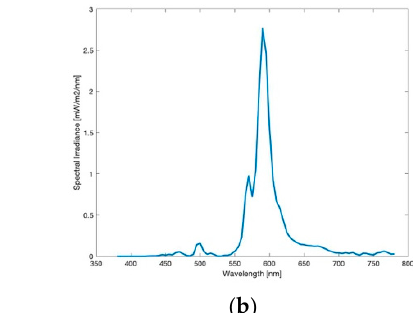
Figure 5. ( a ) Image of the ball light during daytime; ( b ) Spectrum of lamp observed.